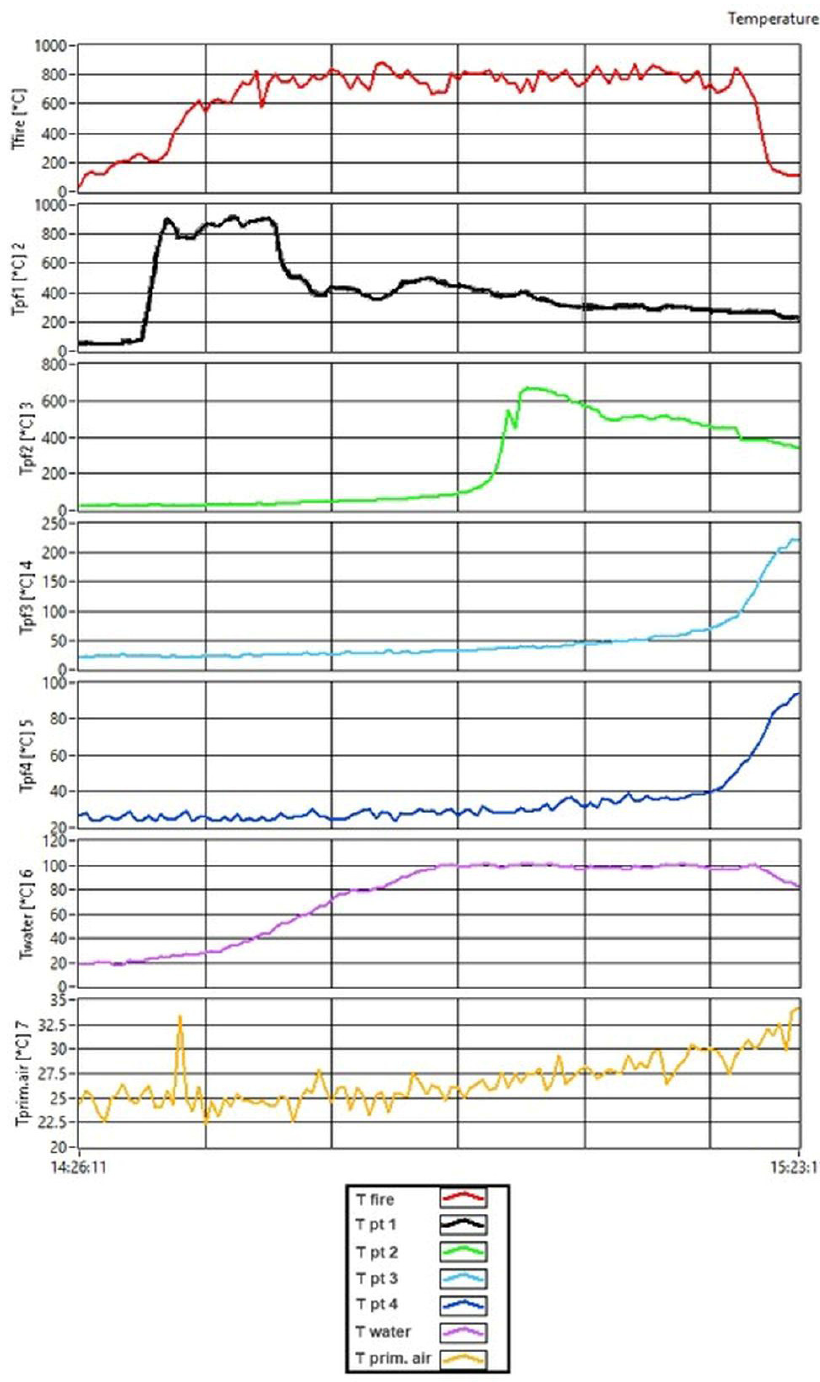
Figure 15. Evolution of temperatures acquired during the test with a ratio of 1/3 and an additional secondary flow rate (30%) of 25/65 L/min.